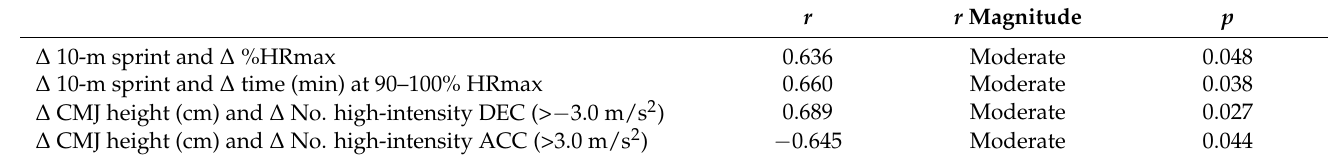
Table 3. Correlations between percentage change ( ∆ ) of match-related loads and percentage change ( ∆ ) of neuromuscular performance and intermittent-running endurance